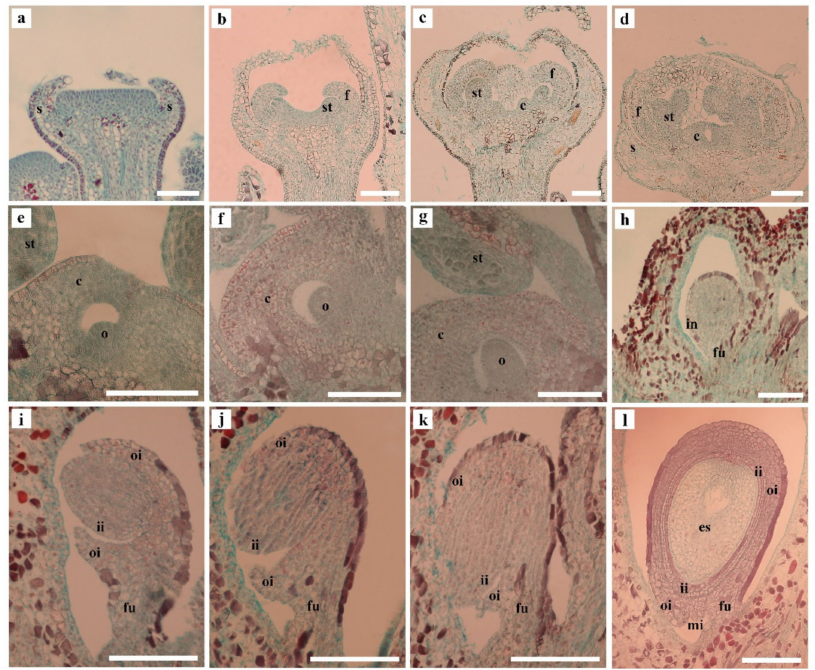
Figure 3. Anatomical structure of ‘Xiangfei’ grape florets in inflorescences at different developmental stages using Safranin O-Fast Green staining. ( a ) Inflorescence length (IL) <1 cm, sepal primordium formed and developed. ( b ) IL: 1–2 cm, flower cap primordium developed, stamen primordium protruded. ( c ) IL: 2–3 cm, carpel primordium formed. ( d ) IL: 3–4 cm, carpel primordium fused. ( e ) IL: 4–5 cm, ovule primordia formed. ( f – h ) IL: 5–8 cm, the development of ovule primordium. ( i – k ) IL: 8–12 cm, the inversion stage of ovules. ( l ) IL: 12–16 cm, the embryo sac began to develop. Scale bars = 200 µ m. o, ovule primordia; s, sepal primordia; f, flower cap primordia; st, stamen primordia; c, carpel primordia; in, integument; oi, outer integument; ii, inner integument; mi, micropyle; es, embryo